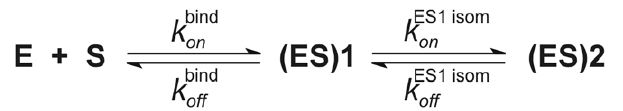
Figure 3. The kinetic scheme describing the interactions of APE1K98A with undamaged ligand.